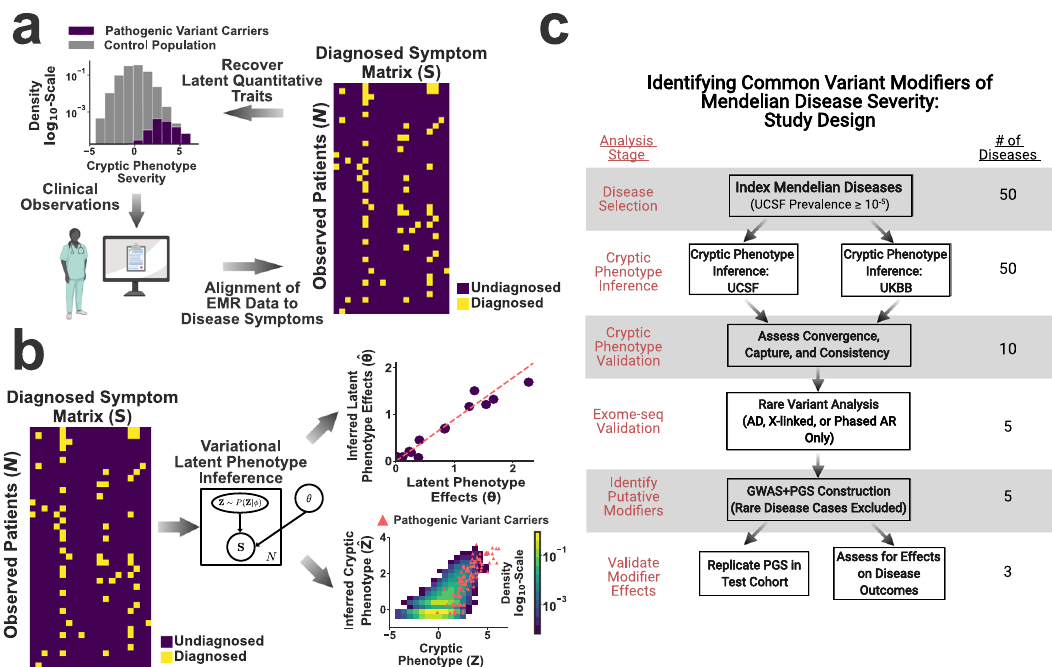
Fig. 1 A phenotype-driven approach to identifying common variant modi fi ers. a Schematic illustrating the assumptions underlying cryptic phenotypes and the proposed work fl ow. b Illustration of the model-based approach to symptom matrix decomposition and cryptic phenotype recovery. c Flow diagram describing the approach to inferring and validating cryptic phenotypes, which were subsequently used to identify common variant modi fi ers. UCSF: UCSF Clinical Data Warehouse; UKBB: UK Biobank. a and c were created using